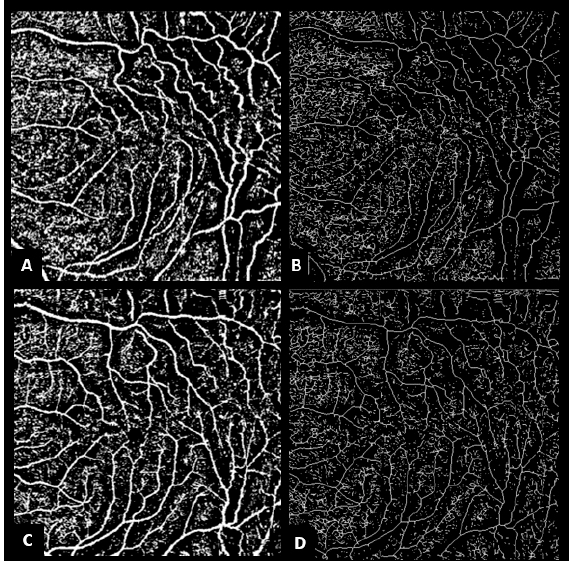
Figure 1. Binarized en-face OCTA images of a 65-year-old female before and after idiopathic epiretinal membrane (iERM) surgery. ( A ) Otsu binarization of en-face OCTA image before iERM surgery. ( B ) Skeleton model of the superficial retinal vascular plexus, retinal vascular tortuosity index was 1.22. ( C ) Otsu binarization of en-face OCTA image after iERM surgery. ( D ) Skeleton model of the superficial retinal vascular plexus, the retinal tortuosity index regressed to 1.17 after surgery.